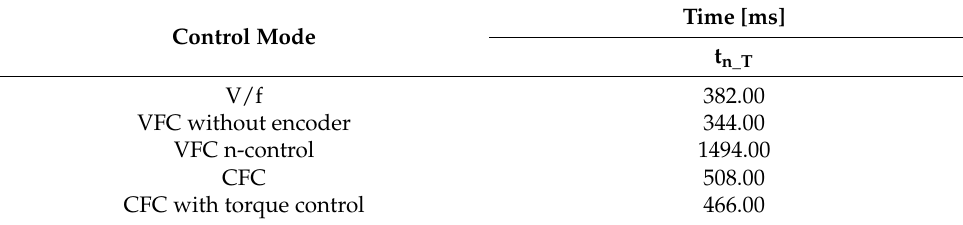
Table 16. Duration of the transient state (t n_T ) for the rotational speed n A (with the external load). Control Mode